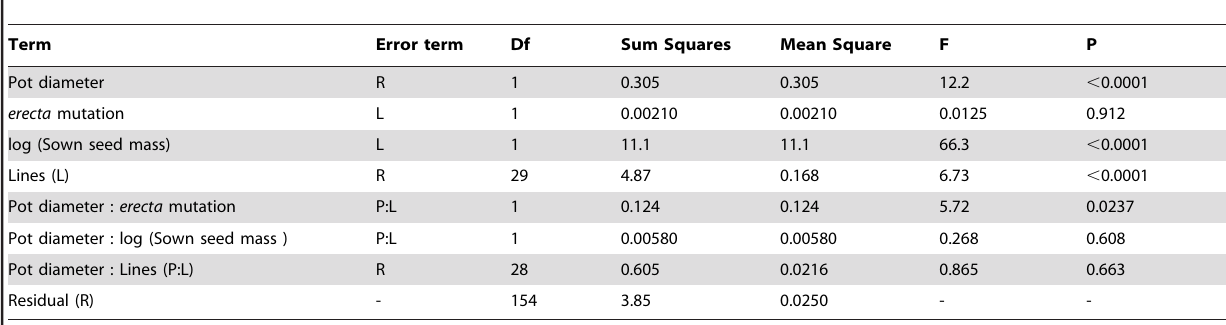
Table 3. ANOVA of harvested seed mass with sown seed mass fitted as an explanatory